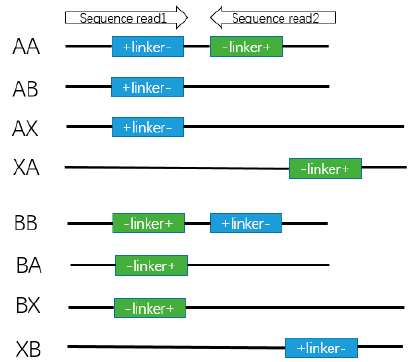
Figure A5. Di ff erent PETs of linker composition. A linker and B linker are from two strands of bridge Figure A5. Different PETs of linker composition. A linker and B linker are from two strands of bridge Figure A5. Different PETs of linker composition. A linker and B linker are from two strands of bridge Figure A5. Different PETs of linker composition. A linker and B linker are from two strands of bridge linker. The letter X means we did not find the linker by sequencing. The combinations of di ff erent linker. The letter X means we did not find the linker by sequencing. The combinations of different linker. The letter X means we did not find the linker by sequencing. The combinations of different linker. The letter X means we did not find the linker by sequencing. The combinations of different linkers are from two reads. For example, AX means that A linker is detected in Read1 and no linker is linkers are from two reads. For example, AX means that A linker is detected in Read1 and no linker is linkers are from two reads. For example, AX means that A linker is detected in Read1 and no linker is linkers are from two reads. For example, AX means that A linker is detected in Read1 and no linker is detected in Read2. detected in Read2. detected in Read2. detected in Read2.